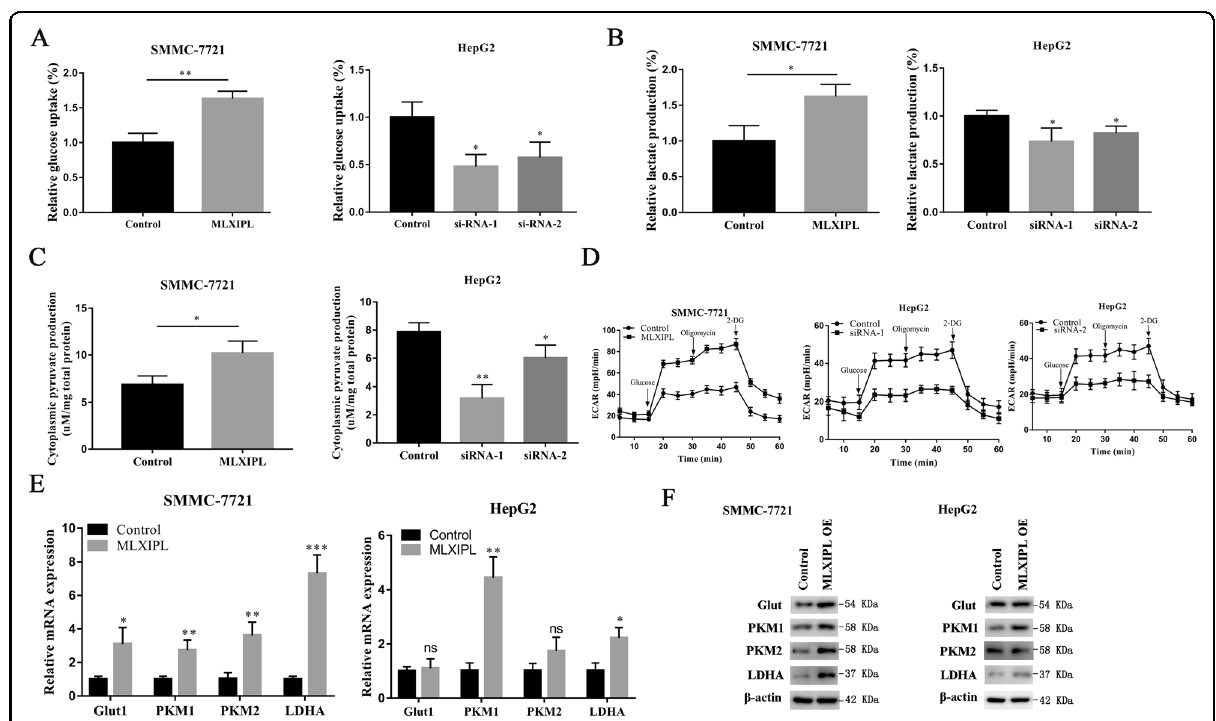
Fig. 7 MLXIPL promotes HCC cell glycolysis in vitro. A SMMC-7721 and HepG2 cells transfected with overexpressed MLXIPL plasmids or MLXIPL siRNAs were cultured for 24 h for glucose uptake assays. * P < 0.05; ** P < 0.01. B Analysis of the production of lactate in SMMC-7721 and HepG2 after transfected with overexpressed MLXIPL plasmids or MLXIPL siRNAs. * P < 0.05. C The transfected cells were lysed and the cytoplasmic levels of pyruvate were detected. * P < 0.05; ** P < 0.01. D The overall glycolytic fl ux of transfected SMMC-7721 and HepG2 cells was analyzed by ECAR using seahorse instrument. E , F Quantitative real-time PCR and western blot were performed to analyze the levels changes of glycolytic key enzymes, when transfected with overexpressed MLXIPL plasmids in SMMC-7721 and HepG2 cells. ns P > 0.05; * P < 0.05; ** P < 0.01; *** P <